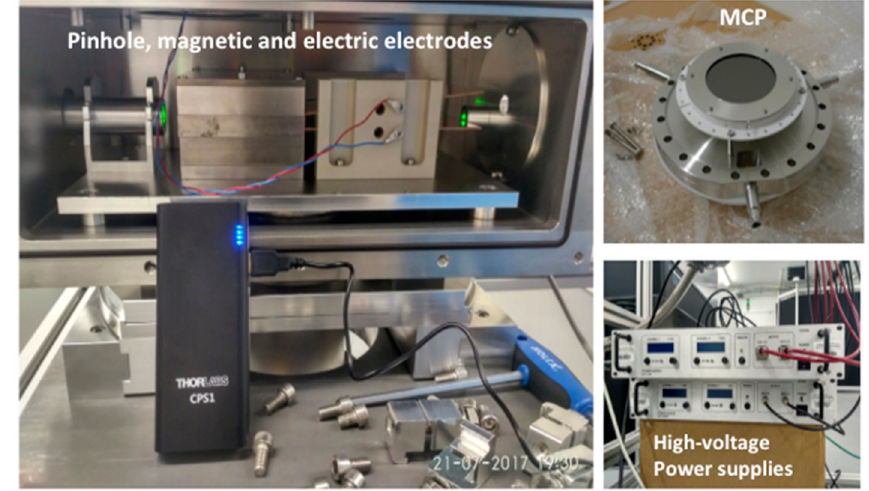
Figure 3. Details of the ELIMAIA TPS: ( left ) pinhole, magnetic and electric electrodes (TPS inside view), ( top right ) micro channel plate and ( bottom right ) high voltage power supplies .